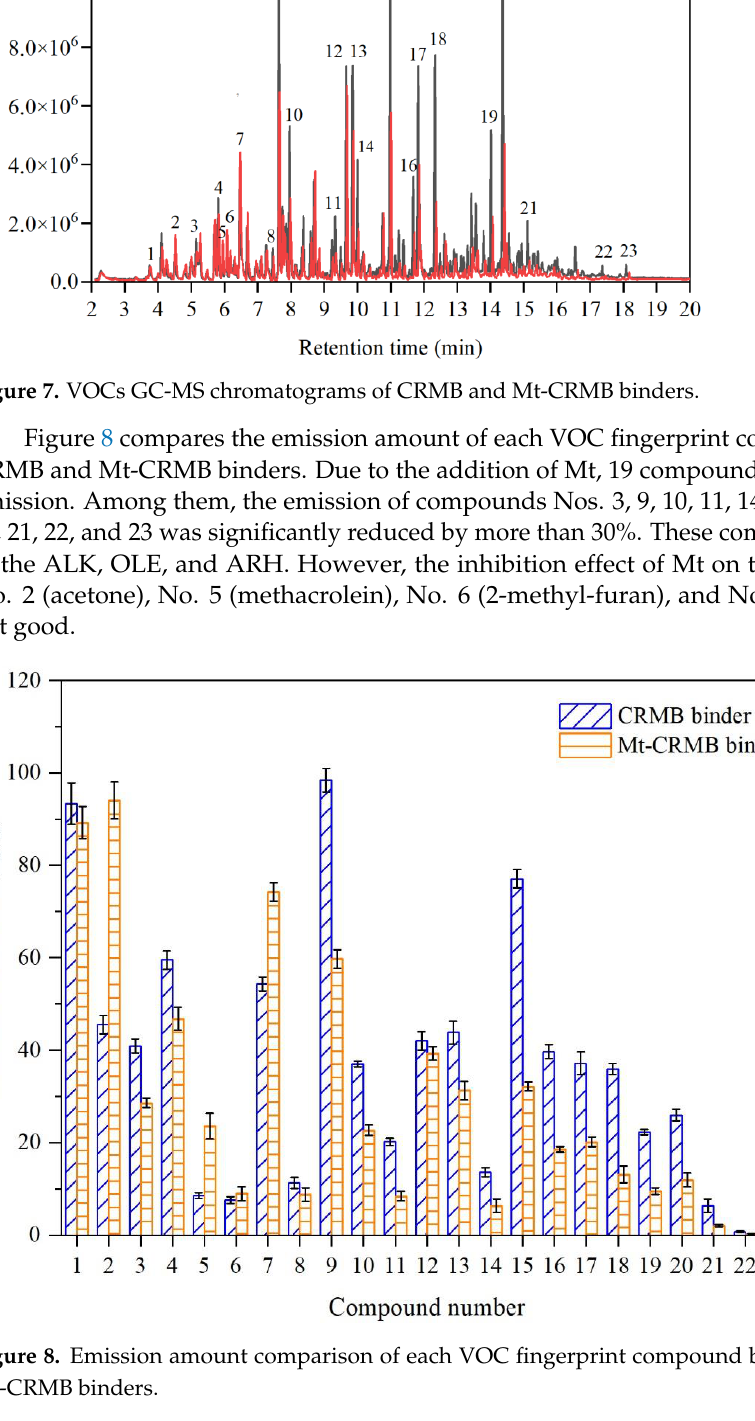
Figure 6. Emission comparison of each VOC fingerprint compound between the base and CRMB binders.